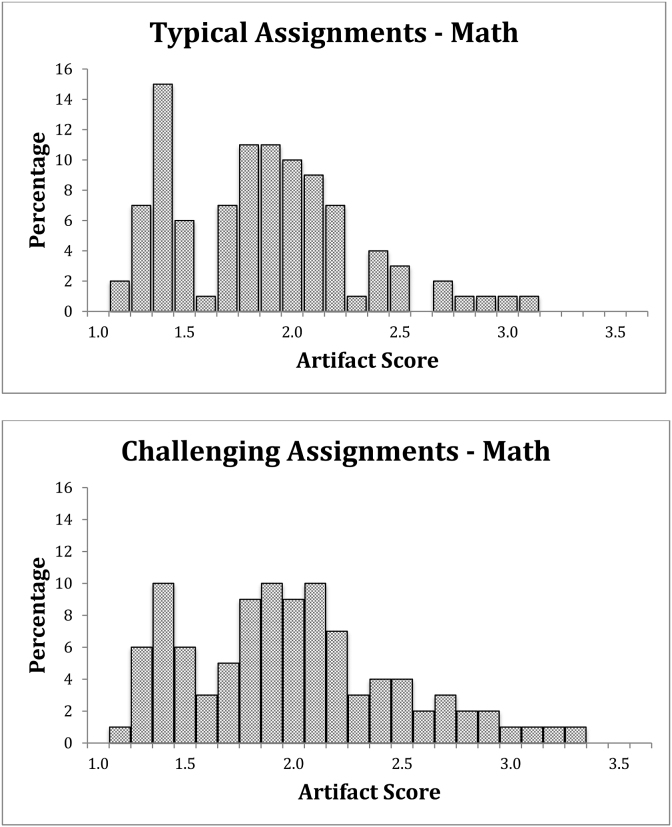
Math assignment score distributions.